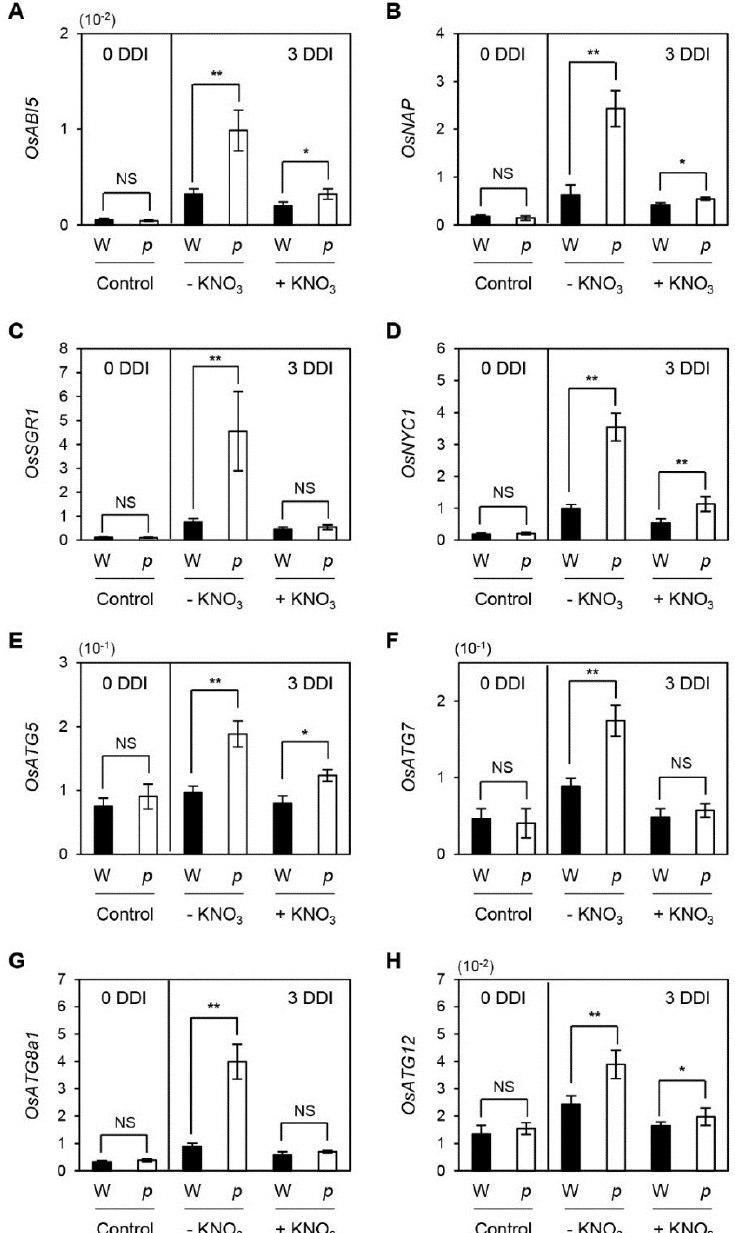
Figure 5. Up-regulation of SAGs in osphyB-2 mutants during DIS rescued by supplementation with KNO 3 . Detached leaf segments from one-month-old WT (W; black bars) and osphyB-2 ( p ; white bars) plants grown under LD conditions were floated on the 3 mM MES (pH 5.8) buffer without (−KNO 3 ) or with 1.9 g/L KNO 3 (+KNO 3 ), with the abaxial side up at 28 °C in darkness, and were sampled at 0 (control) and 3 DDI for RT-qPCR. RT-qPCR analysis was used to measure the relative transcript levels of OsABI5 ( A ); OsNAP ( B ); OsSGR1 ( C ); OsNYC1 ( D ); OsATG5 ( E ); OsATG7 ( F ); OsATG8a1 ( G ); and OsATG12 ( H ); and their transcript levels were normalized to the transcript levels of OsUBQ5 . Mean and SD values were obtained from more than three biological replicates. These experiments were repeated twice with similar results. Asterisks indicate significant difference between WT and osphyB-2 (Student’s t -test p values, * p < 0.05; ** p < 0.01). DDI, day(s) of dark incubation; NS, not